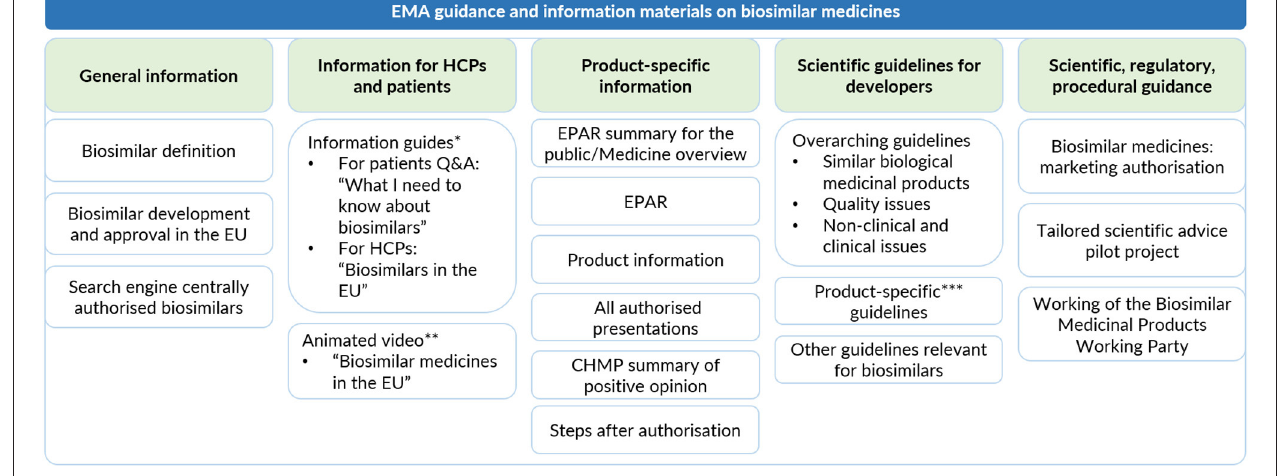
FIGURE 2 | Overview of EMA’s information material and guidance documents on biosimilar medicines. * Available in 23 official EU languages. ** Available in English and other EU languages (Dutch, English, French, German, Italian, Polish, Portuguese, Spanish). *** For recombinant granulocyte-colony stimulating factor,